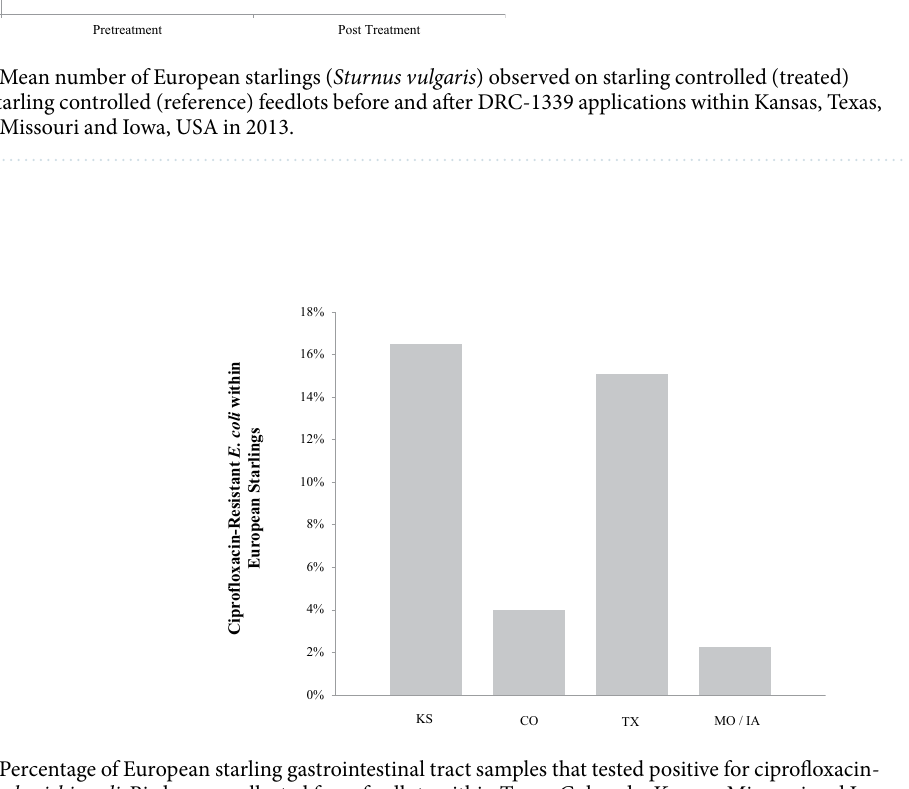
Figure 2. Percentage of European starling gastrointestinal tract samples that tested positive for ciprofloxacin- resistant Escherichia coli . Birds were collected from feedlots within Texas, Colorado, Kansas, Missouri and Iowa between December 2012 and April